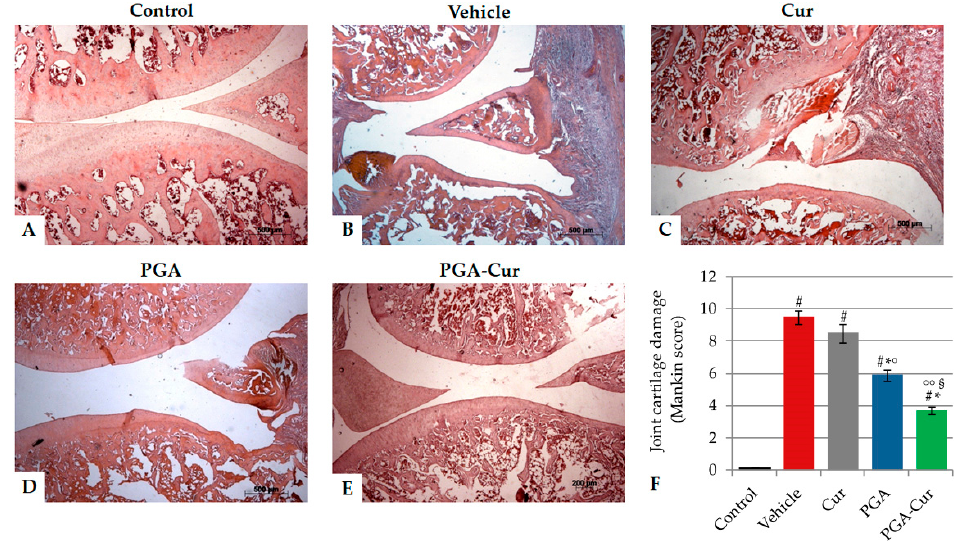
Figure 5. Protective e ff ect of the study compounds on monoiodoacetate -induced histological damage to the knee joint cartilage. Representative images of hematoxylin and eosin (H&E)-stained sections in the sagittal plane. Tibiofemoral joints injected with MIA showed erosion and roughening of the articular cartilage, microfractures in the fibrocartilage, as well as expansion of the synovial membrane ( B ) compared to control joints ( A ). Curcumin 10 mg / kg ( C ) and PGA 20 mg / kg ( D ) administered alone exerted a little protective e ff ect against joint damage. The oral administration of PGA co-ultramicronized with curcumin (PGA-Cur, 30 mg / kg) counteracted the histological damage to a higher extent ( E ), as also shown by the greater and significantly higher decrease in the severity score of the osteochondral damage (i.e., modified Mankin score, F). Values are means ± standard error of the mean of 10 animals for each group. See text for further details. # p < 0.0001 vs. control; * p < 0.0001 vs. vehicle; ◦ p < 0.05 and ◦◦ p < 0.0001 vs. Cur; § p < 0.0001 vs.